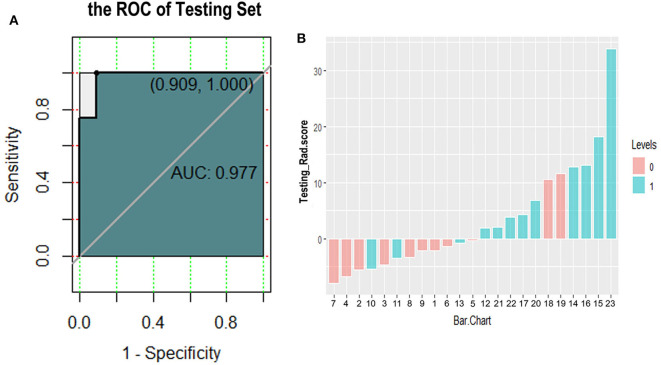
Receiver operating characteristic curve (A) and classification effect diagram (B) for verifying the model with testing data. (A) The area under the curve is 0.977, the sensitivity is 1.0, and the specificity is 0.909 in testing data. (B) Pink and blue represent label 0 and label 1 according to the gold standard, respectively. The model uses 0 as the classification threshold, with blues <0 and pinks >0 being cases of model misclassification. It can be seen that the classification effect of the model in the testing group is generally good.